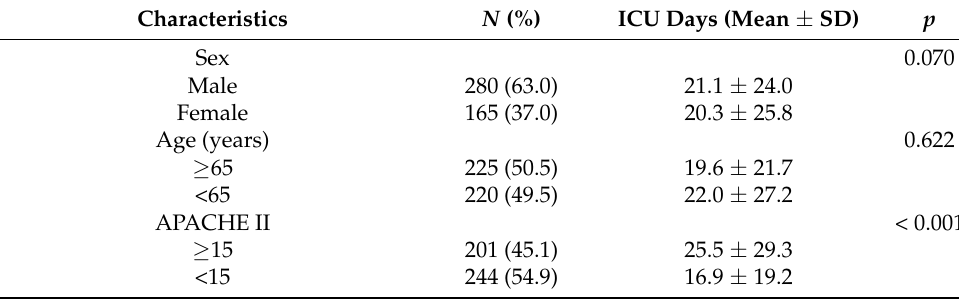
Table 4. Association of patient characteristics with ICU length of